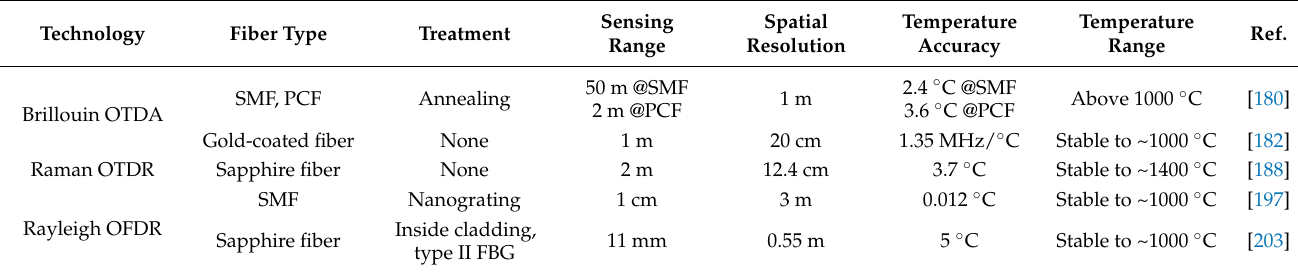
Table 7. Comparison of distributed